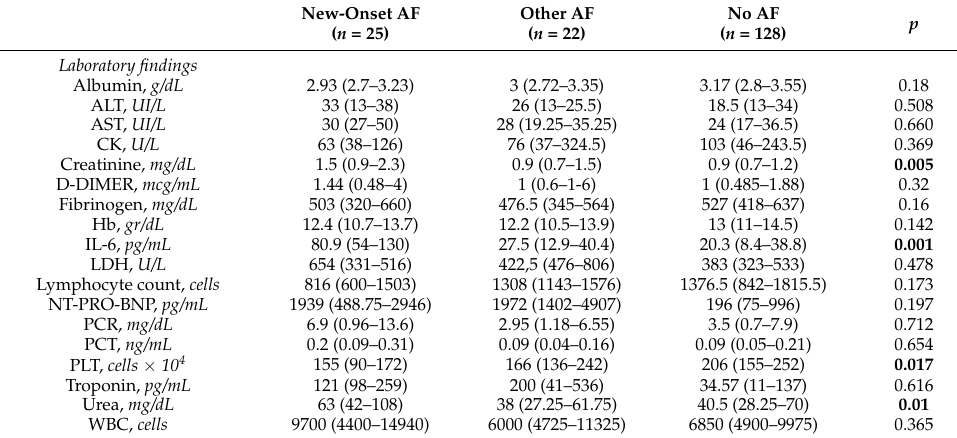
Table 2. Laboratory profile of study population at